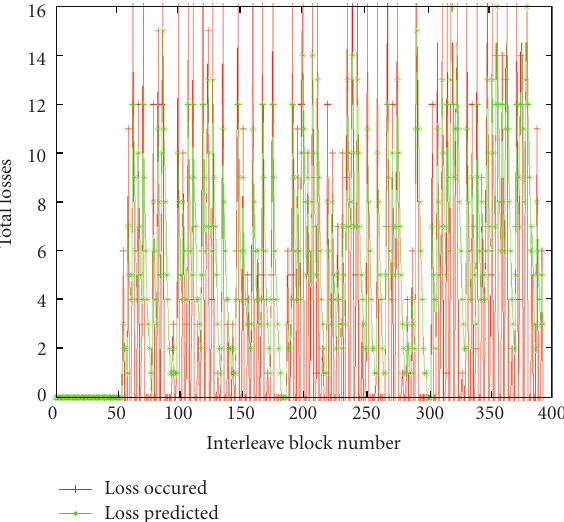
Figure 14: Performance of prediction for “ all ” sequence at 64 kbps, random delay 0.02, bu ff er size 250, packet size 256, span 16, PL rate